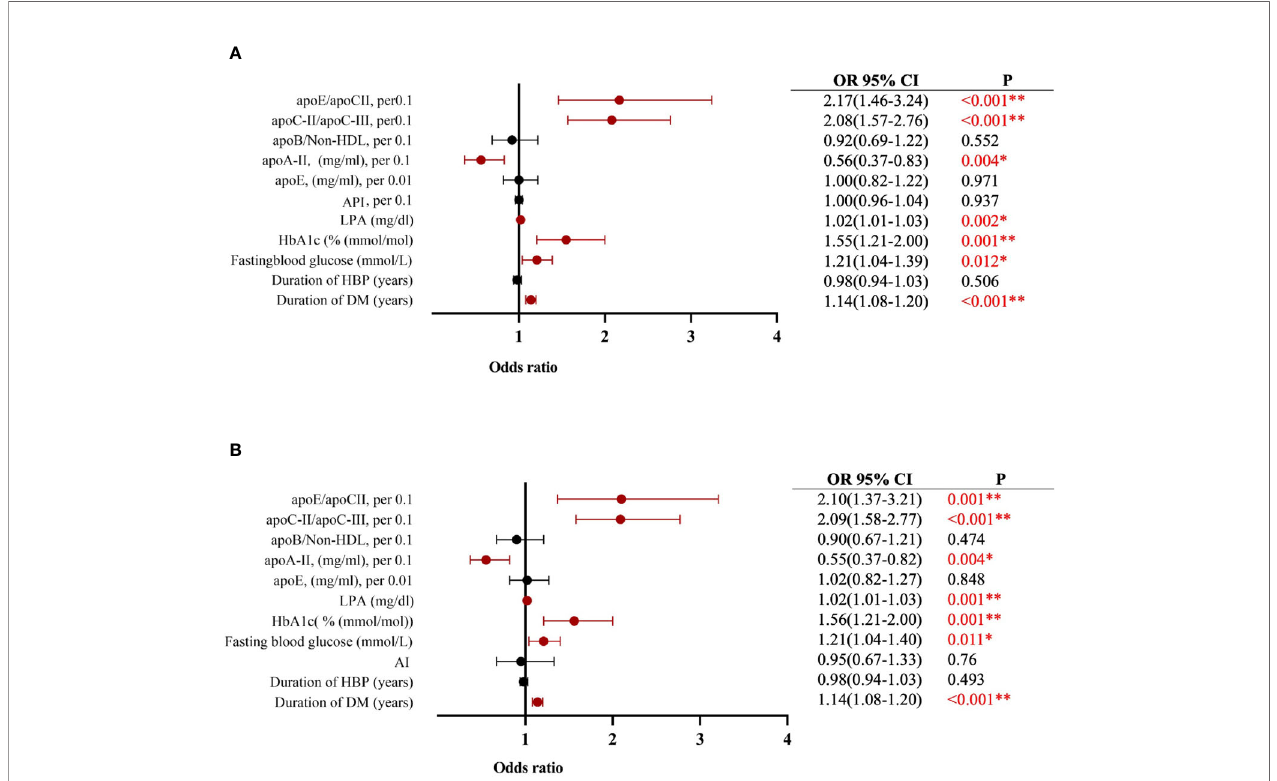
FIGURE 3 | Multiple-variable ordered logistic model showing (A) apoC-II/apoC-III and apoE/apoc-II contribute to DM and DR associated with DM duration, fasting glucose, hemoglobin, and lipoprotein a; apoA-II is a protector for DM and DR (when was considered as an independent variable). (B) Multiple-variable ordered logistic model showing apoC-II/apoC-III and apoE/apoc-II contribute to DM and DR associated with DM duration, fasting glucose, hemoglobin and lipoprotein (a; apoA-II is a protector for DM and DR when AI was considered as an independent variable). The histograms on the right side represent the data distribution of LPA (mg/dl). *Statistically signi fi cant: p ≤ 0.05. **Statistically signi fi cant: p ≤ 0.001. DM, diabetes mellitus; apo, apolipoprotein; HbA1c, glycated hemoglobin, LPA, lipoprotein a. API: LDL-C/HDL-C; AI: